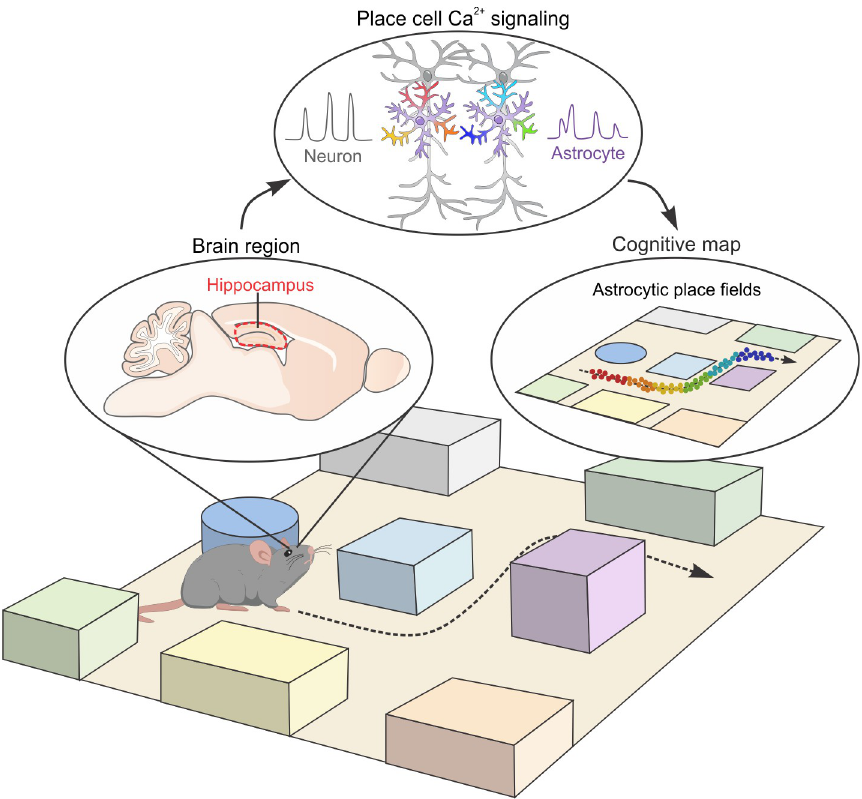
Fig 1. Cognitive map and underlying cellular mechanisms. A cognitive map encodes spatial information and allows navigational planning. The hippocampus is a key structure containing cells responsible for constructing the cognitive map in the mammalian brain. Hippocampal neurons known as place cells become electrically active when the animal travels to specific locations within its environment. Using 2-photon in vivo Ca 2+ imaging, Curreli and colleagues provide evidence that hippocampal astrocytes respond to spatial locations in a virtual reality environment with elevations in their intracellular Ca 2+ signals. Moreover, the information contained by hippocampal astrocytes is not a passive copy of nearby neuronal information. The tantalizing unanswered question is whether astrocytes are active partners with neurons in generating a spatial cognitive map.